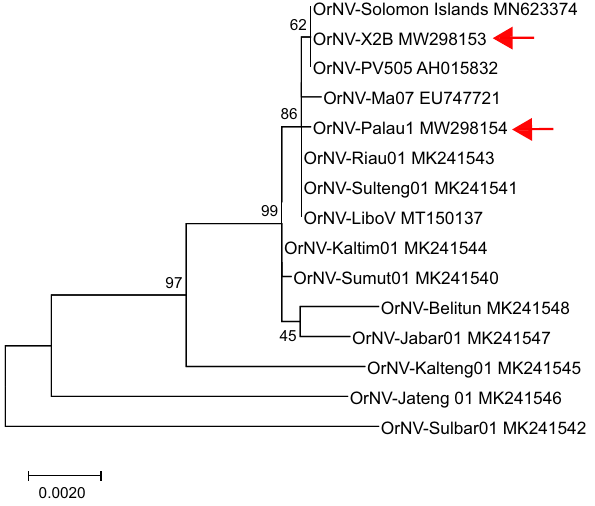
Figure 6. Relationships among OrNV isolates inferred from alignment of DNA polymerase nucleotide sequences. A midpoint-rooted phylogram inferred by maximum likelihood is shown, with bootstrap support (%) indicated. The positions of sequences from OrNV-X2B and OrNV-Palau1 are indicated by red arrows in the